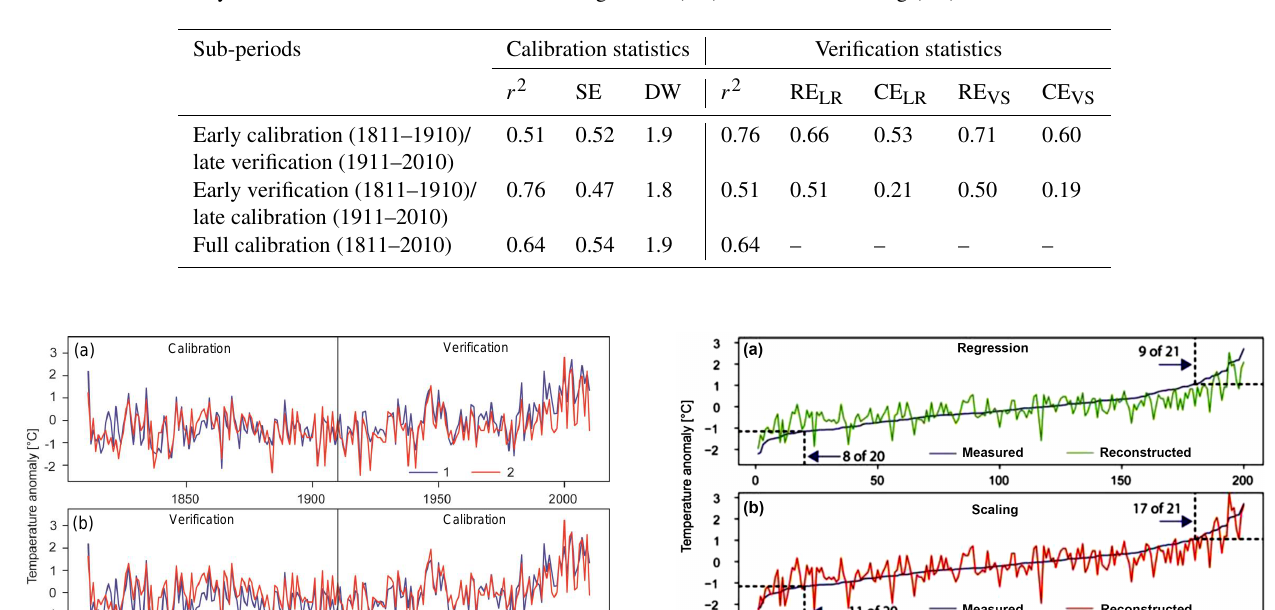
Table 1. Summary of calibration and verification statistics used for April–August temperature reconstruction based on grape-harvest dates for the Czech Lands: r 2 – explained variance; SE – standard error of estimate; DW – Durbin–Watson test; RE – reduction of error; CE – coefficient of efficiency. RE and CE were calculated for linear regression (LR) and variance scaling (VS).